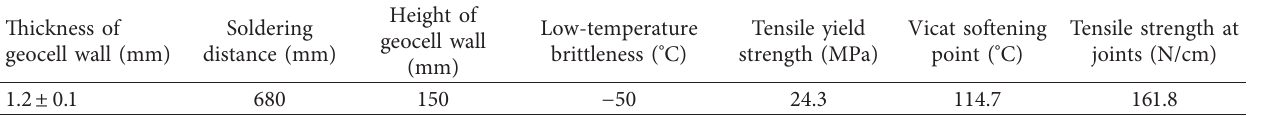
Table 2: Geocell